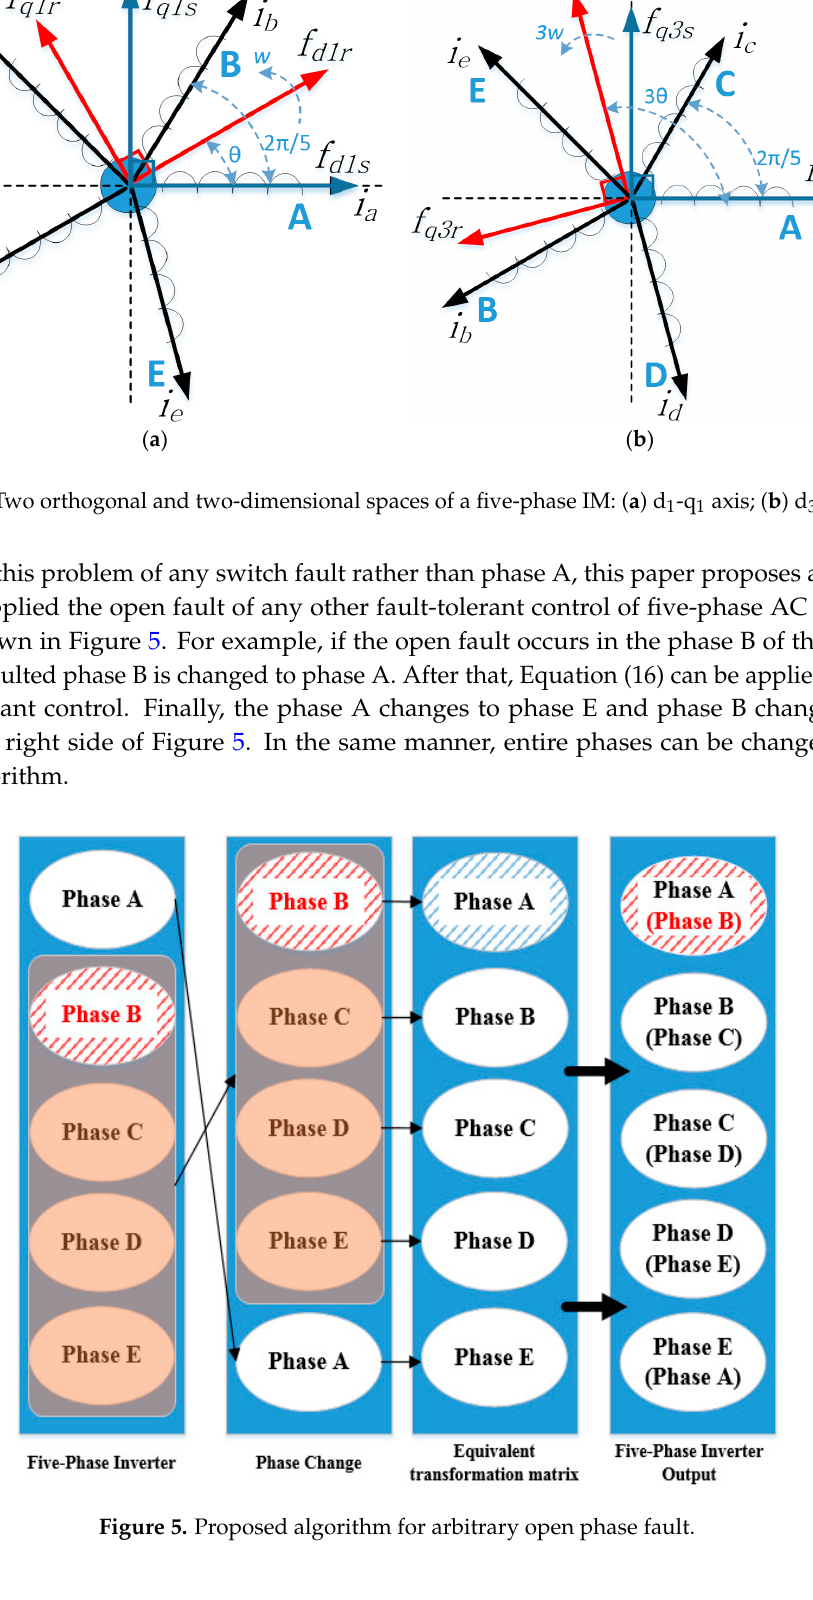
Figure 6. Flow chart for fault detection and fault ‐ tolerant control under arbitrary phase open fault. In this paper, the fault ‐ tolerant control is used to minimize copper loss under the one fault condition [24]. From the voltage equation of the five ‐ phase IM, the torque equation can be expressed as Equation (17) in a synchronous frame: